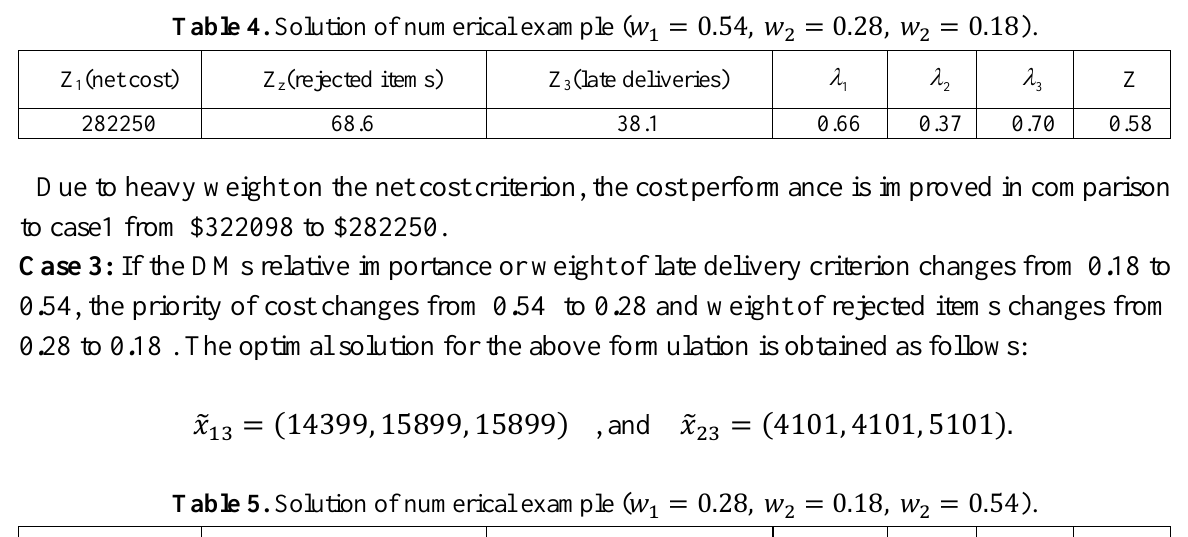
Table 4. Solution of numerical example ( 𝑤